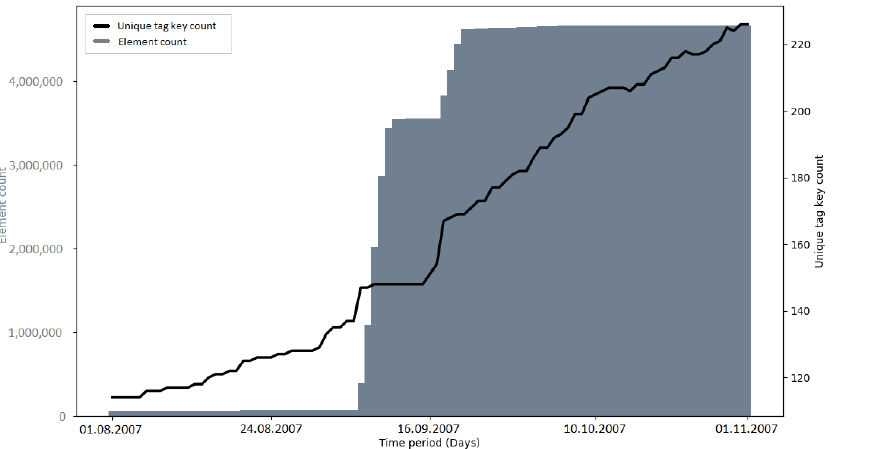
Figure A16. Number of tag keys during the AND import.